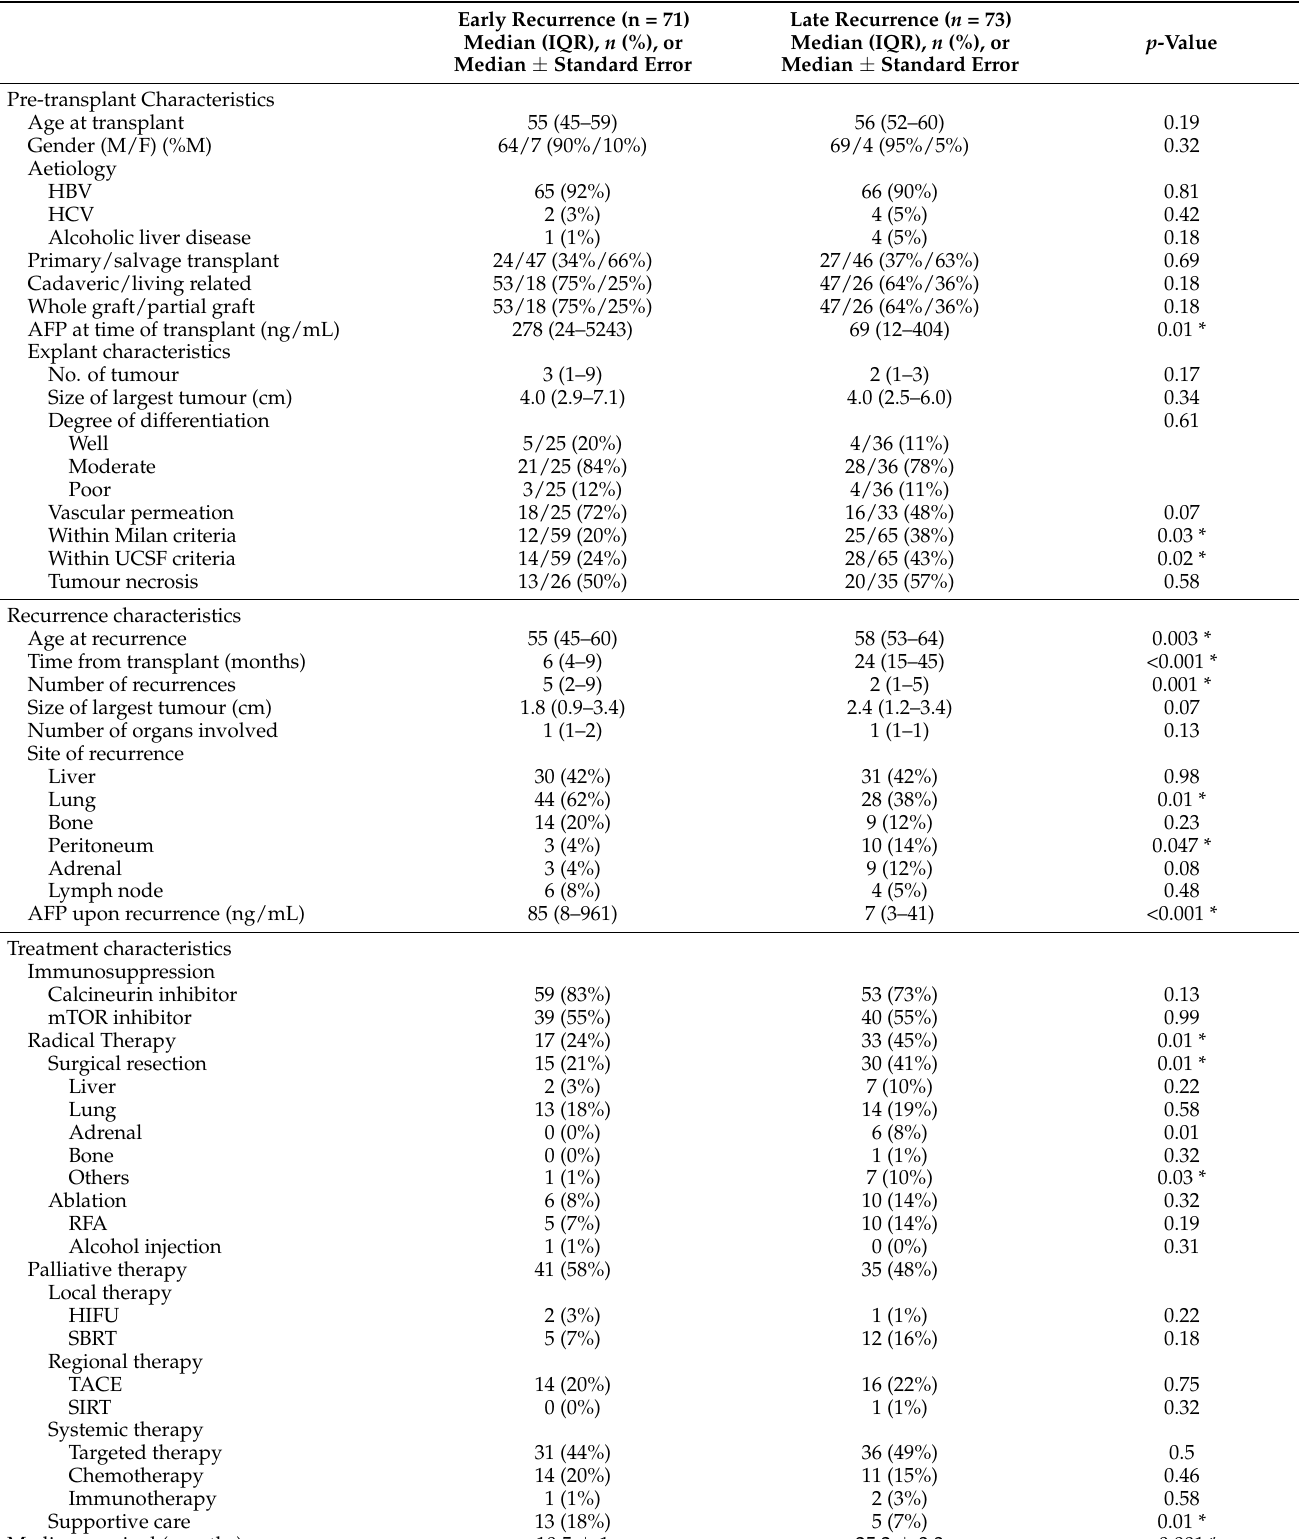
Table 3. Characteristics of patients with early versus late